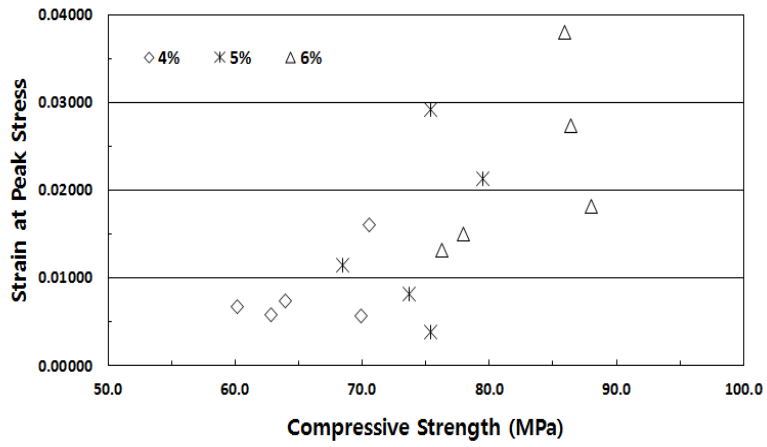
Figure 5. Strain at peak stress.